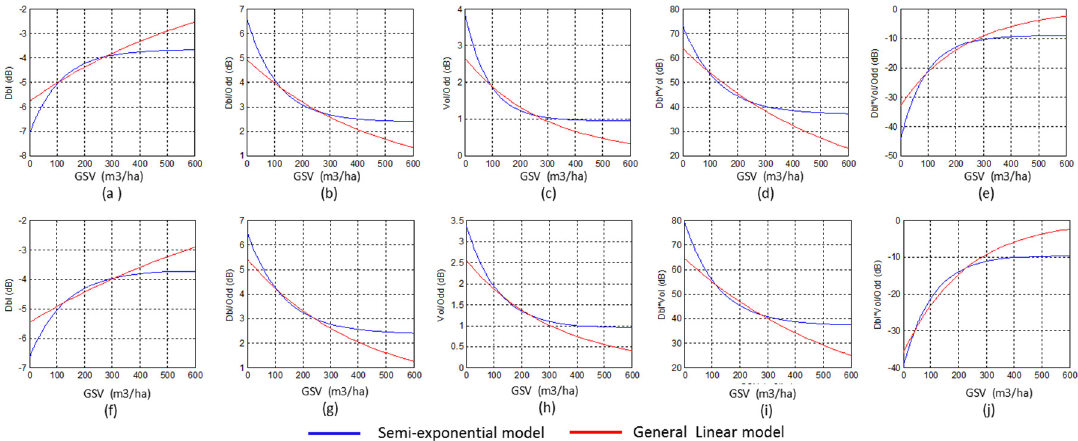
Figure 8. Comparison between the GSV estimated by GLM and the semi-exponential model using the variables from ( a – e ) time series images acquired on 30 June and 22 September 2016 (1, 4 in Table 5), and ( f – j ) time series images acquired on 30 June, 14 July, 25 August and 22 September 2016 (1, 2, 3, 4 in Table 5).